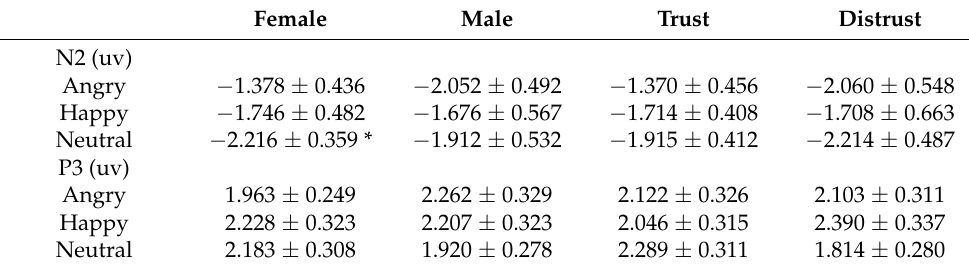
Table 3. The average mean amplitudes of N2 and P3 in the making-choices stage.